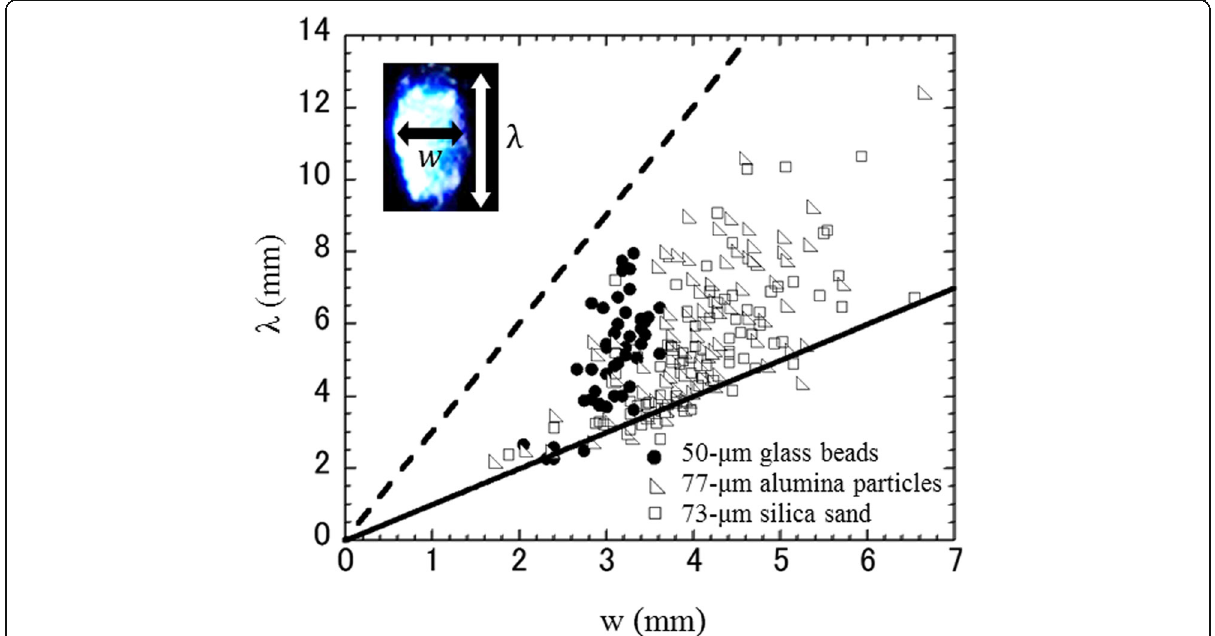
Fig. 13 Agglomerate length λ (mm) versus agglomerate width w (mm). Filled circle, open square, and triangle show 50 μ m glass bead, silica sand, and alumina particles, respectively. The solid line is the ratio λ /w=1, and the dashed line is λ